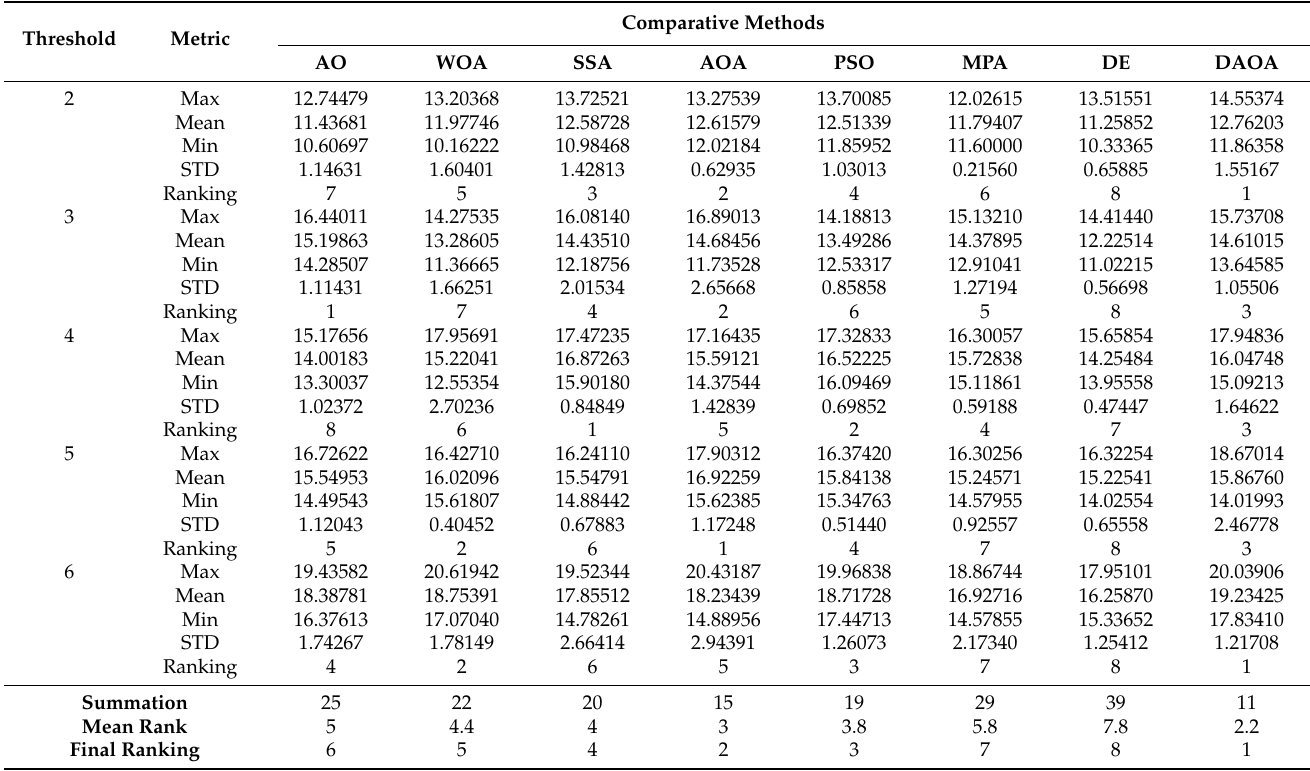
Table 2. The PSNR results of the test case 1.